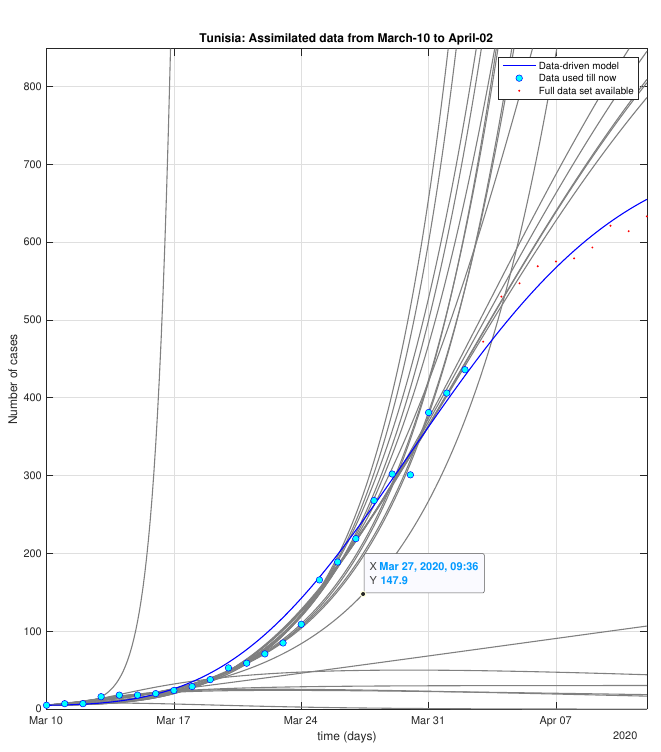
Figure 49. Tunisia: Sequential data-driven